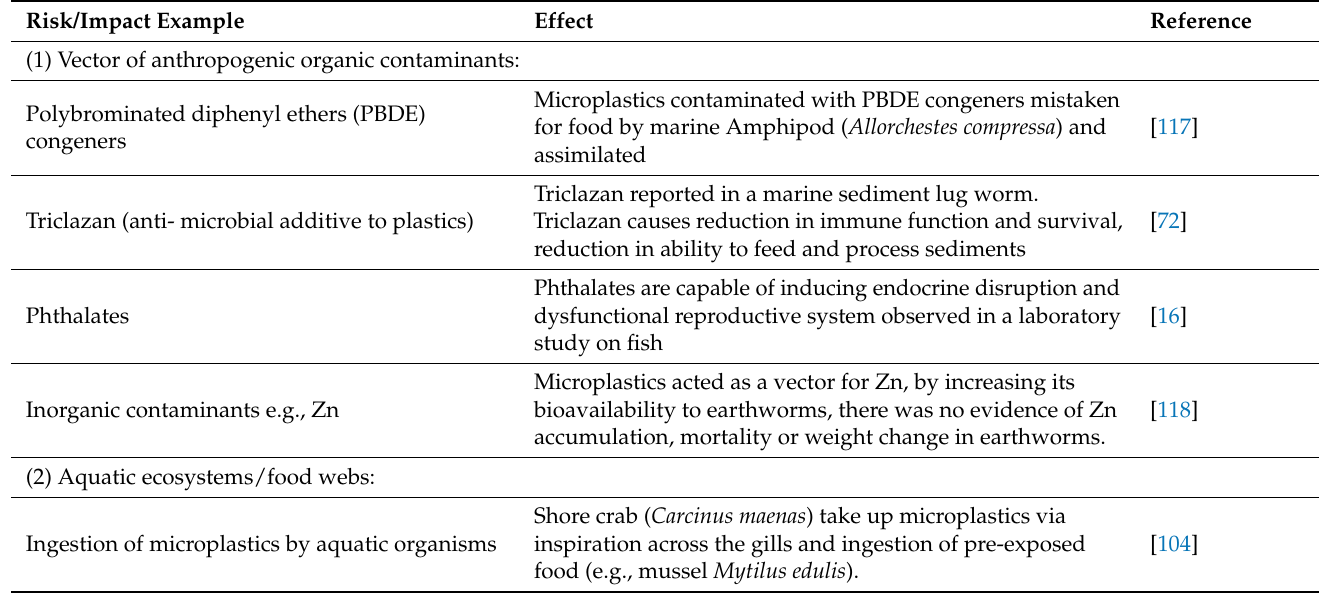
Table 1. Summary environmental, ecological and potential public health risks/impacts of microplastics in aquatic systems. Risk/Impact